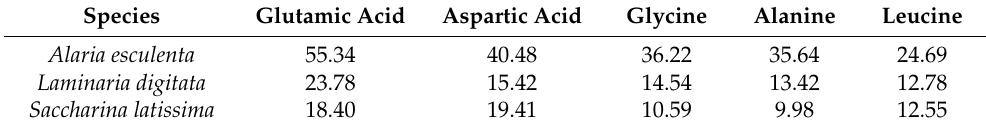
Table 2. The top five amino acids (mg g − 1 ) found in each of the three seaweed species studied [9]. Species Glutamic Acid Aspartic Acid Glycine Alanine Leucine Alaria esculenta 55.34 40.48 36.22 35.64 24.69 Laminaria digitata 23.78 15.42 14.54 13.42 12.78 Saccharina latissima 18.40 19.41 10.59 9.98